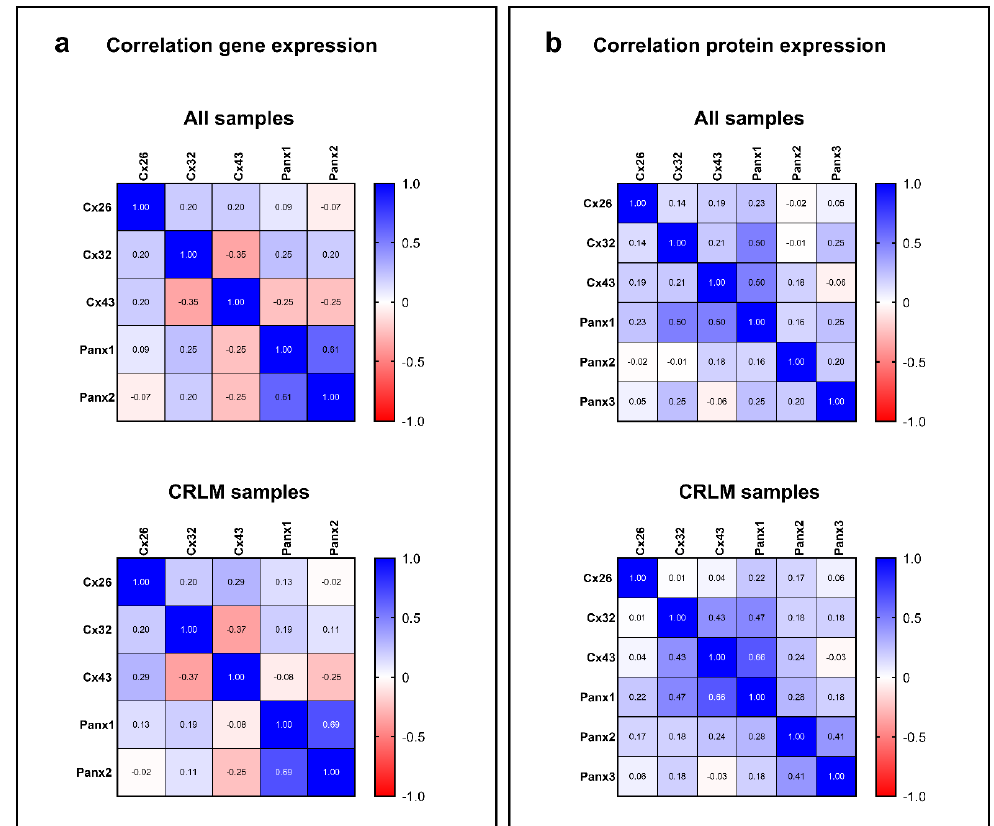
Figure 5: Correlation between Cx and Panx expression in human liver disease. The heat maps represent the Spearman's rank correlation coefficients between Cx and Panx gene ( a ) and protein ( b ) expression. Total RNA was extracted from the human liver biopsies and used for RT-qPCR analysis of Cx26, Cx32, Cx43, Panx1, Panx2 and Panx3. Relative fold gene expression compared to a pooled sample was calculated with the Pfaffl method (Pfaffl, 2001). Total protein was extracted from the human liver biopsies and used for immunoblotting analysis of Cx26, Cx32, Cx43, Panx1, Panx2 and Panx3. Protein levels were normalized to the total protein loading and expressed as a ratio to a pooled